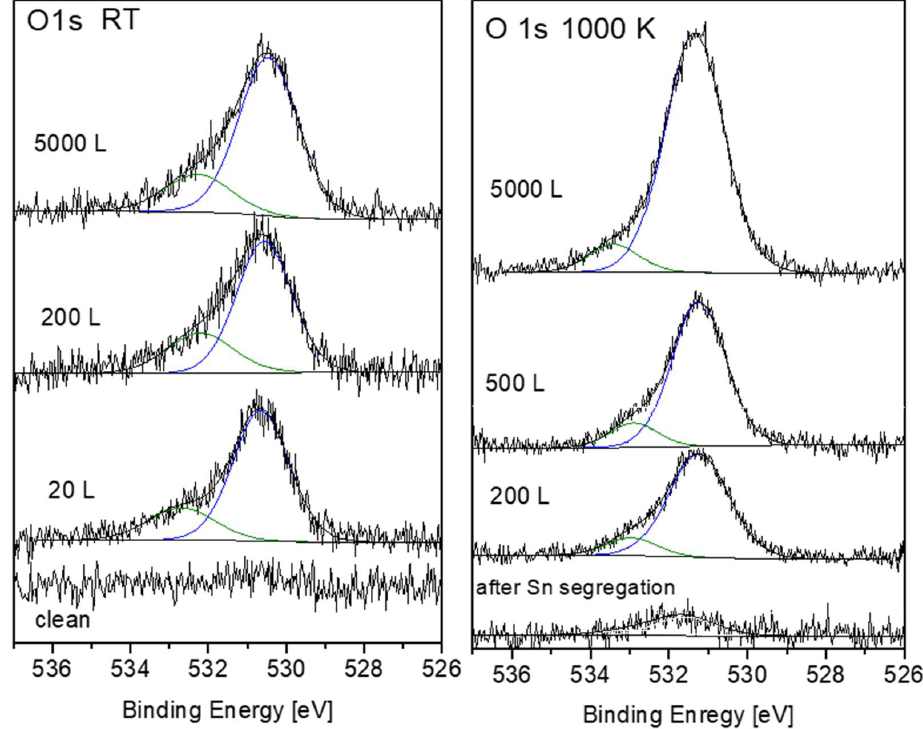
Figure 13. Representative O 1s spectra and peak fittings after oxygen exposure at RT and 1000 K.